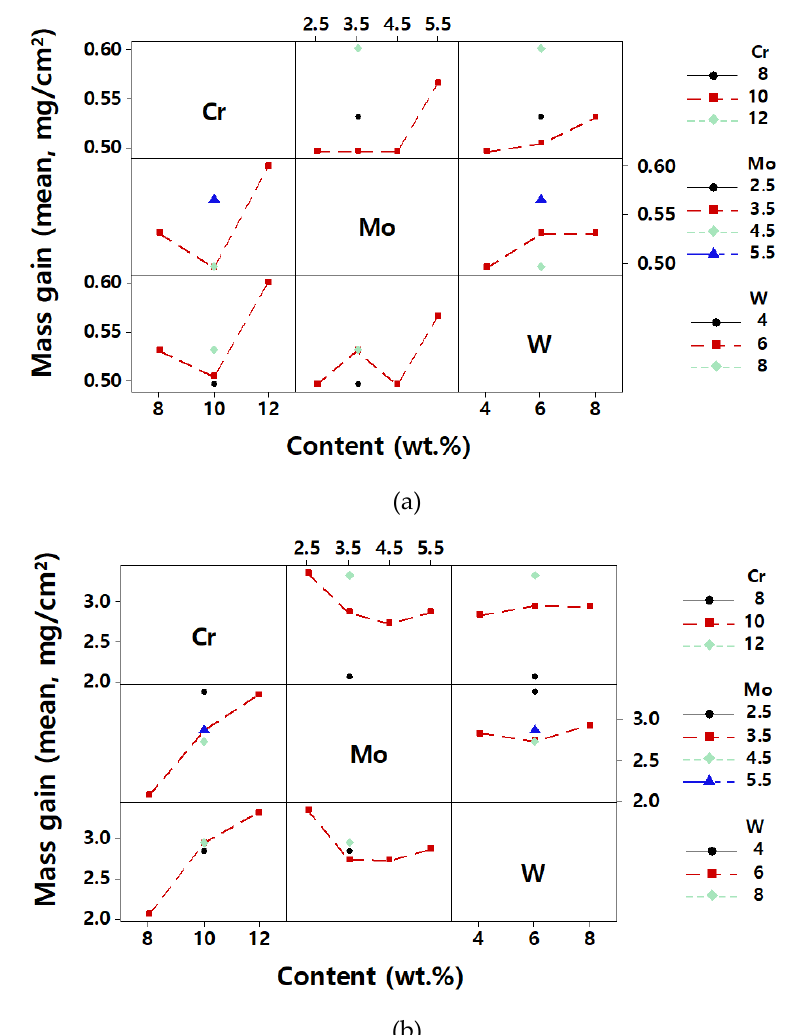
Figure 3. Final mass gain as a function of Cr, Mo, and W contents ( a ) at 850 °C and ( b ) at 1000 °C.